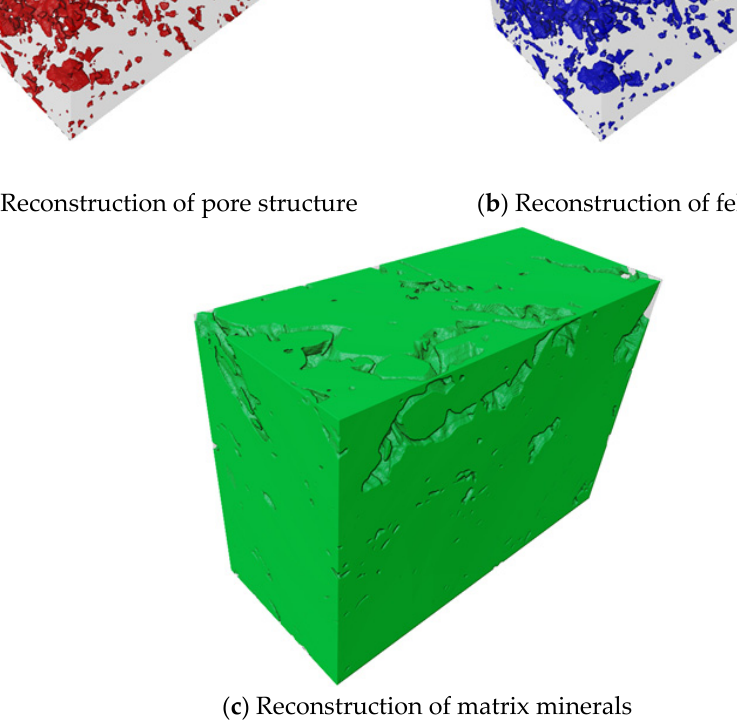
Figure 12. Reconstruction of different pores and minerals.